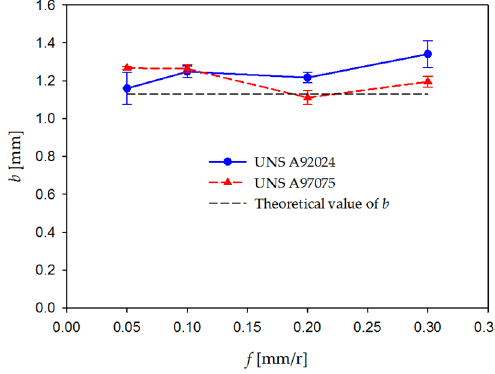
Figure 11. Chip width ( b ) as a function of feed.